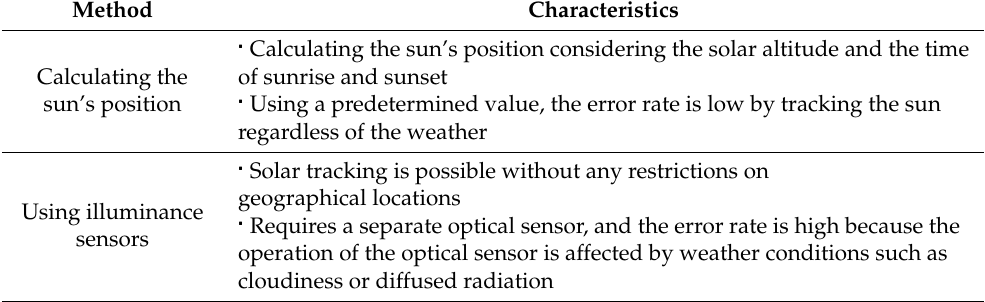
Table 2. Solar tracking